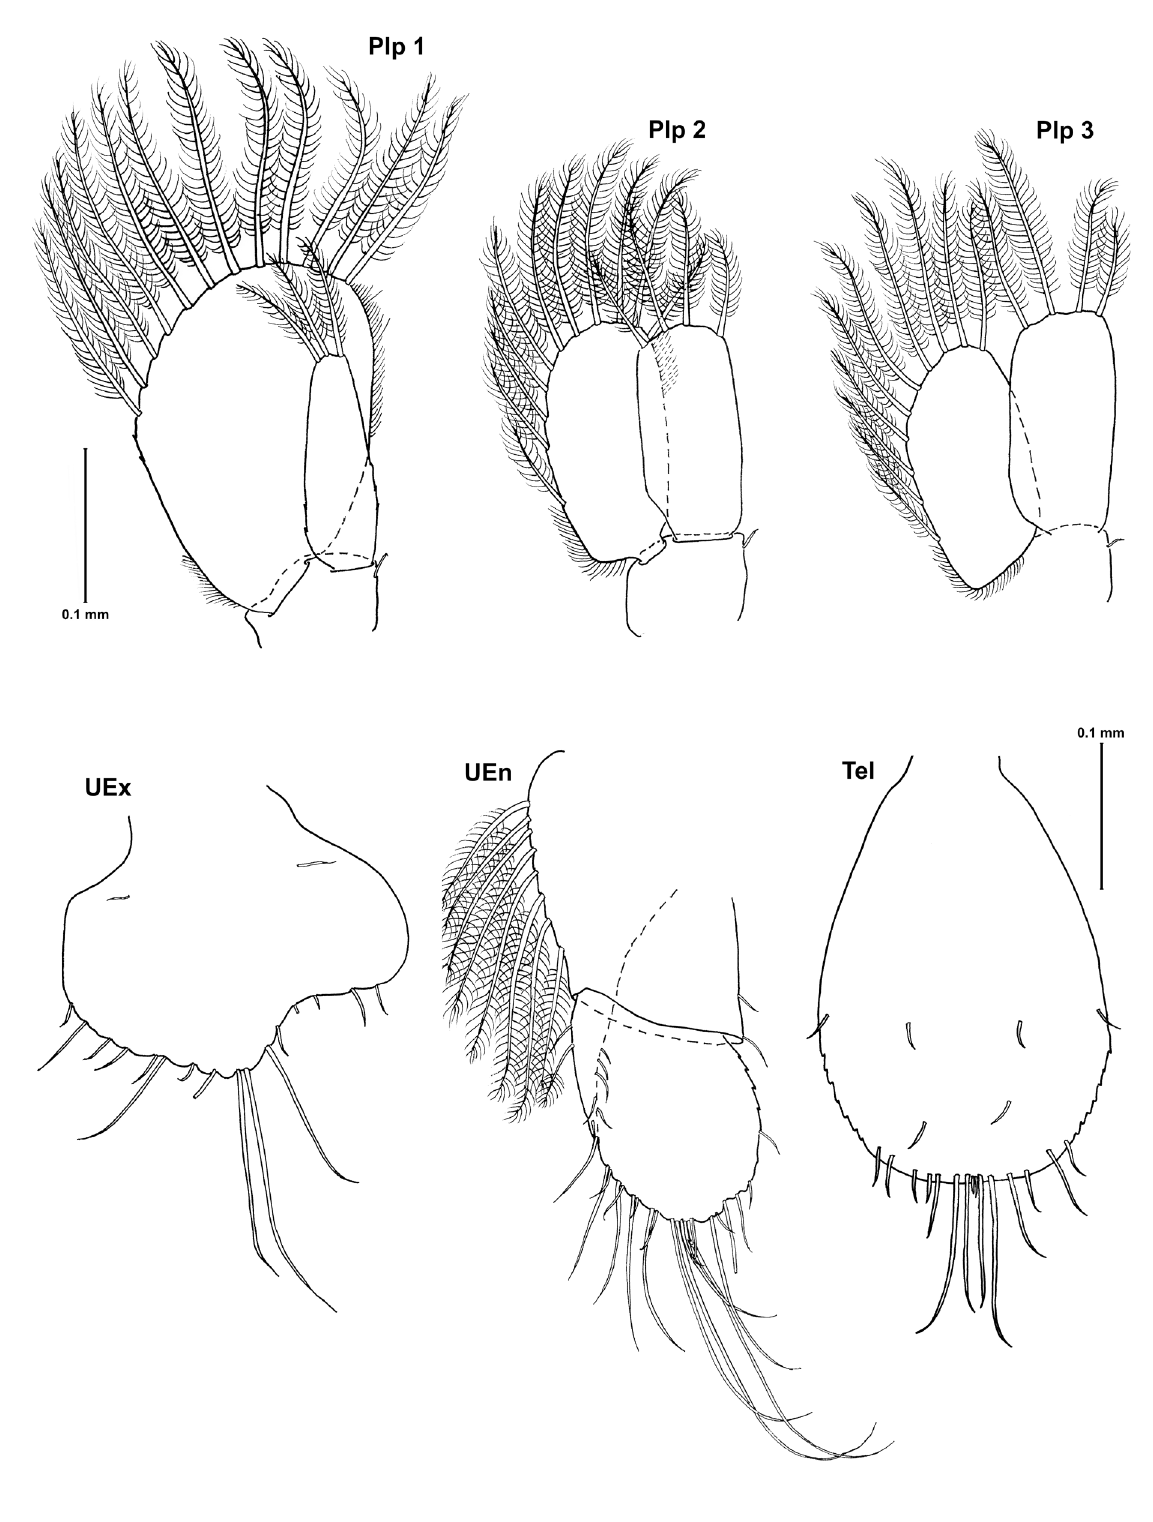
Fig. 20. Expanathura collaris (Kensley, 1979) (MZB Iso 106). Ovigerous ♀ from Bangka Island. Abbreviations: Plp 1–3 = pleopods 1–3; UEx = exopod of uropod; UEn = endopod of uropod; Tel =